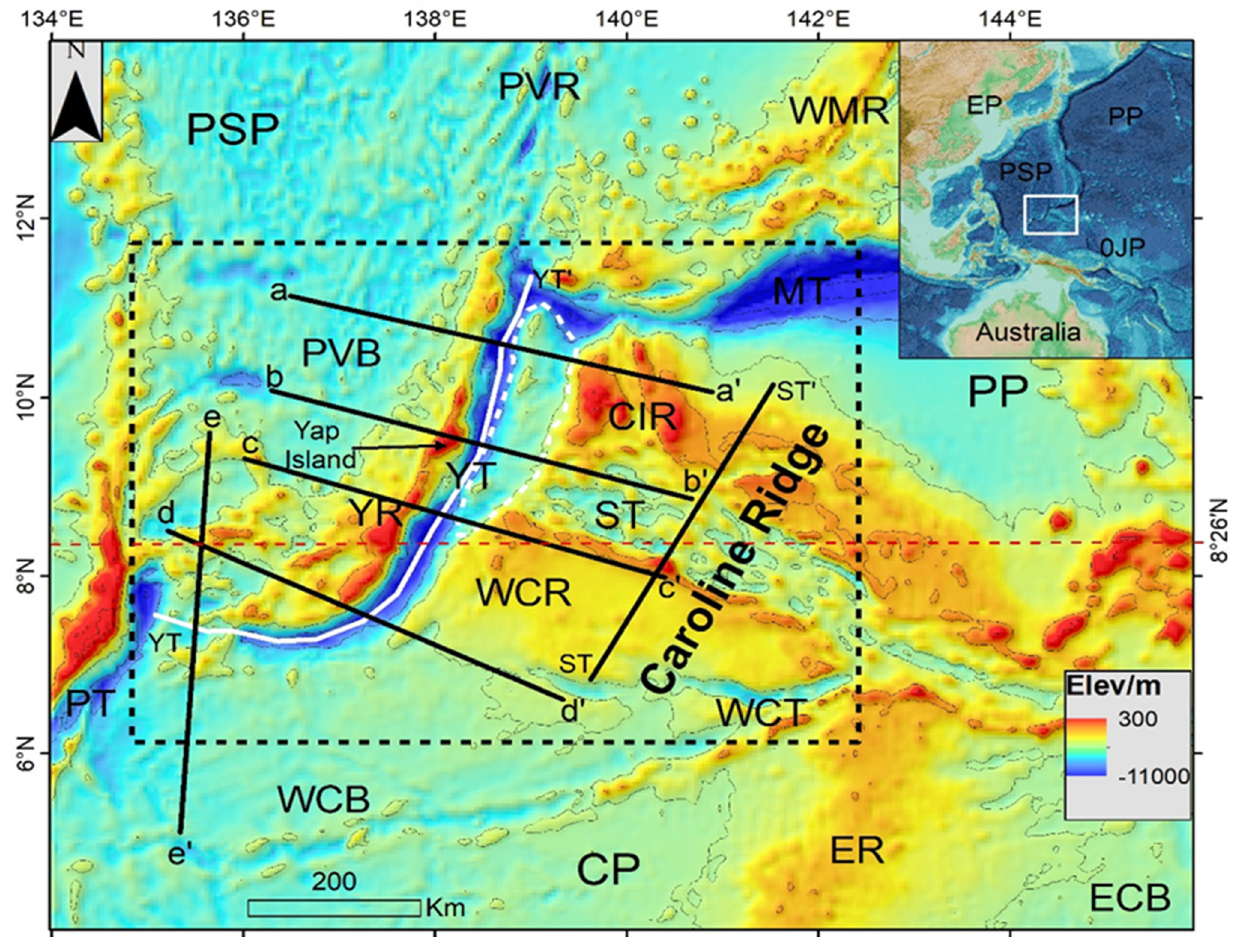
Figure 1. Location of the YSZ and the neighboring regions. The bathymetry information is derived from the GEBCO_2021 data [29]. The white box on an overview sketch represents the position of Figure 1 in the real world. The black-dashed rectangle depicts the survey region, as represented in Figures 2, 5, 7, and 8. The white-dashed polygon defines the area with horsts and grabens [1,4,14]. According to the location of the subducting CR relative to the Yap Trench, the YSZ is divided into two sections by the red-dashed line at 8°26 ′ N [1], with the north segment of YSZ corresponding to the subducting Caroline Island Ridges, Sorol Trough, and the northernmost West Caroline Rise and the south segment of YSZ corresponding to the subducting southernmost West Caroline Rise and West Caroline Basin. The line segments aa ′ , bb’, cc’, dd’, and ee’ represent the position of the 2D comprehensive geophysical profiles across the Yap Trench axis as represented in Figures 3 and 9, respectively. The J-shaped solid white line segment YTYT’ represents the Yap Trench axis, and the 2D comprehensive geophysical profiles along the Yap Trench axis are represented in Figure 4. The line segment STST’ represents the location of the 2D comprehensive geophysical profiles across the Sorol Trough as shown in Figure 10. Abbreviations: CIR: Caroline Island Ridges, EP: Eurasian Plate,